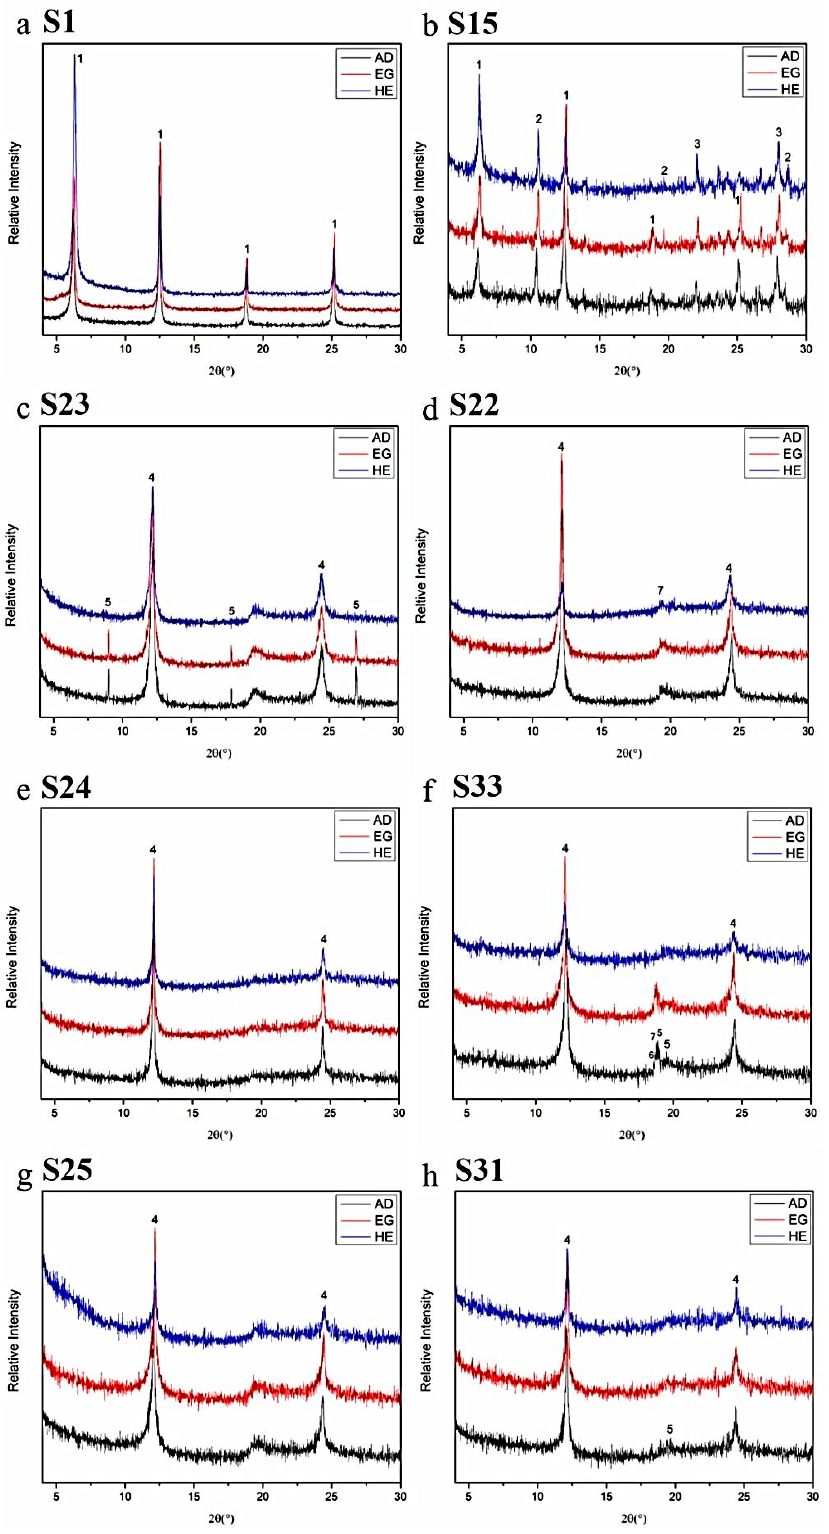
Figure 5. X-ray diffraction patterns of the clay fraction of representative examined samples: ( a ) gabbro (Group II), ( b ) gabbro (Group II), ( c ) serpentinized harzburgite (Group III), ( d ) serpentinized harzburgite (Group III), ( e ) serpentinized harzburgite (Group III), ( f ) serpentinized dunite (Group III), ( g ) serpentinized harzburgite (Group III), ( h ) serpentinized lherzolite (Group III) (AD: air-dried, EG: glycolated, HE: heated, 1: chlorite, 2: amphibole, 3: plagioclase, 4: serpentine, 5: talc, 6: brucite, 7: spinel).